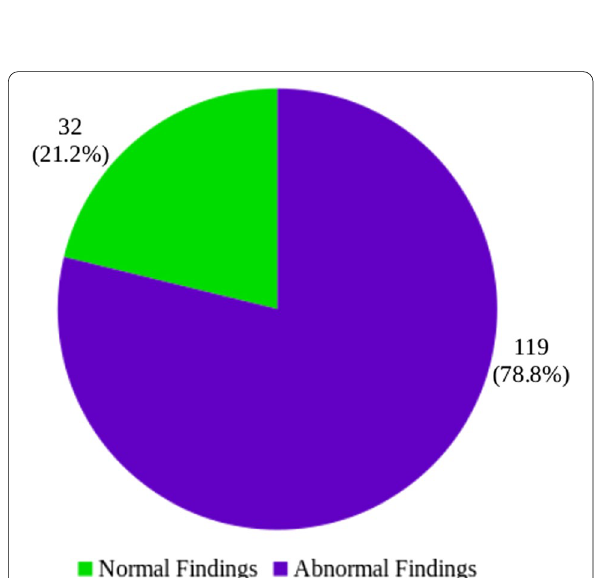
Fig. 1 Distribution of the state of findings from the venous Doppler ultrasound